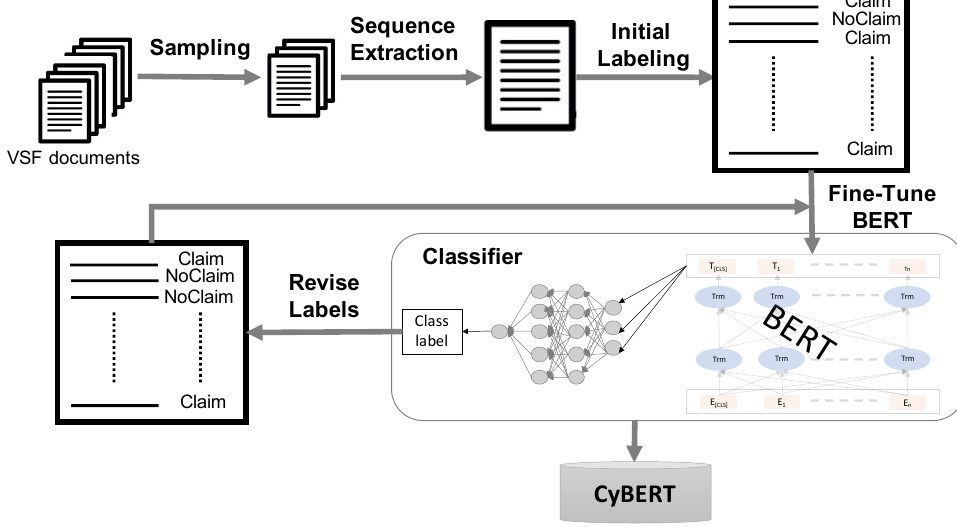
Figure 2. Overview of CyBERT